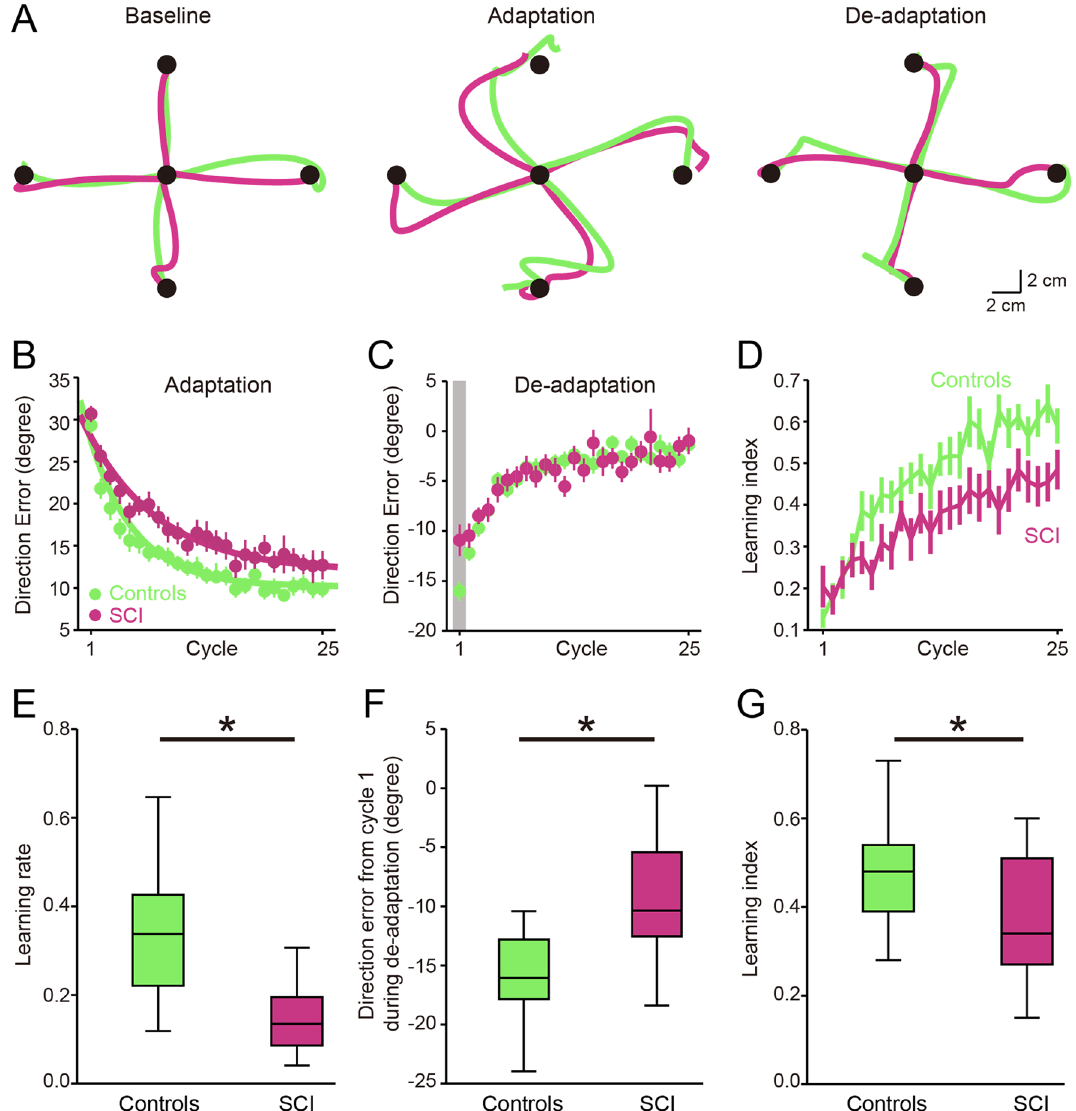
Figure 2. Visuo-motor rotation task. ( A ) Hand-paths of a representative control (green) and SCI (magenta) subject. Hand-paths in the left panel represent the last four consecutive trials observed during the baseline session; hand-paths in middle and right panels represent the first four consecutive trials observed during the adaptation and de-adaptation sessions, respectively. ( B , C ), Group data showing changes in direction errors at peak tangential arm velocity during the adaptation ( B ) and de-adaptation ( C ) sessions. Each data point shown on the x-axis represents the average of four consecutive trials (one cycle). The 25 cycles cover all the 100 trials. ( D ) Learning index for control and SCI subjects. Each learning index is composed of four consecutive trials (one cycle). The 25 cycles cover all the 100 trials. ( E – G ) Box-plot group data showing learning rate of errors during the adaptation session ( E ), direction errors from the first cycle during the de-adaptation session ( F ), and mean learning index during the adaptation session ( G ). Error bars indicate SDs. *p < progressively decreased throughout the session in both groups but to a lesser extent in SCI compared with control subjects (Fig. 2B). After-effects were present when the visual rotation was removed during the de-adaptation ses- sion and decreased with subsequent reaching movements in both groups (Fig. 2C). Repeated measures ANOVA also showed an effect of GROUP (F (1, 42) = 11.8, p = 0.004) and CYCLE (F (2, 84) = 362.3, p < 0.001) on the learning index. The learning index progressive increased throughout the session but to a lesser extent in SCI compared with control subjects (Fig. 2D). Consistently, we found that learning rate of errors was higher in controls com- pared with SCI subjects (controls = 0.34 ± 0.16, SCI = 0.16 ± 0.13, p = 0.001; Fig. 2E). Direction errors from the first cycle during de-adaptation were larger in controls compared with SCI subjects (controls = − 15.6 ± 4.1°, SCI = − 10.1 ± 7.8°, p = 0.01; Fig. 2F). SCI subjects showed lower mean learning index compared with control sub- jects during the adaptation session (controls = 0.47 ± 0.12, SCI = 0.36 ± 0.16; p = 0.01; Fig. 2G). During the adapta- tion session, SCI subjects (0.76 ± 0.08 s) showed an increase in arm deceleration compared with control subjects